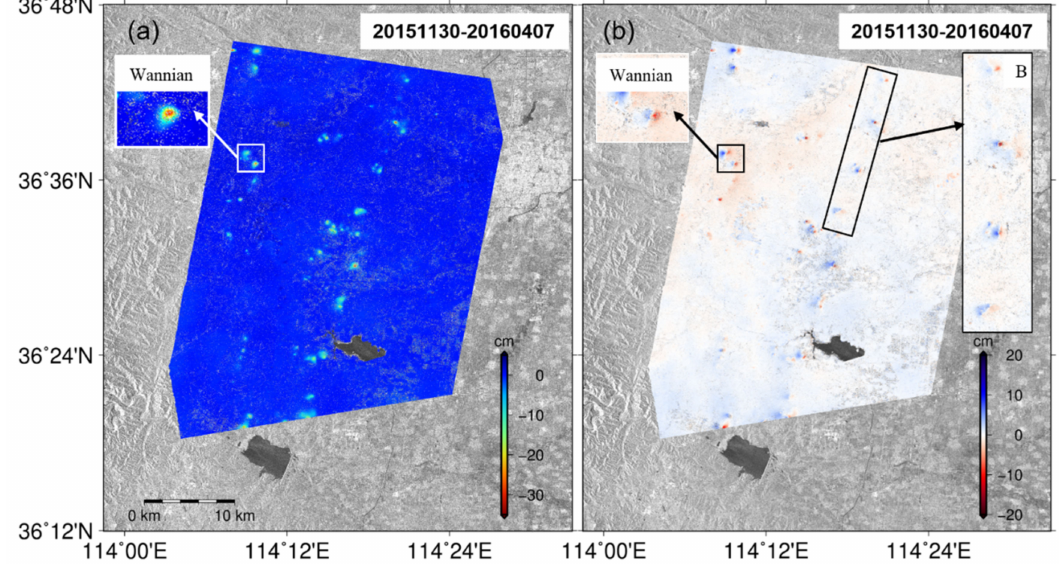
Figure 10. ( a ) The subsidence map and ( b ) horizontal displacement map of the Fengfeng mine area with TSX, Sentinel-1A and Radarsat-2 from 20151219 to